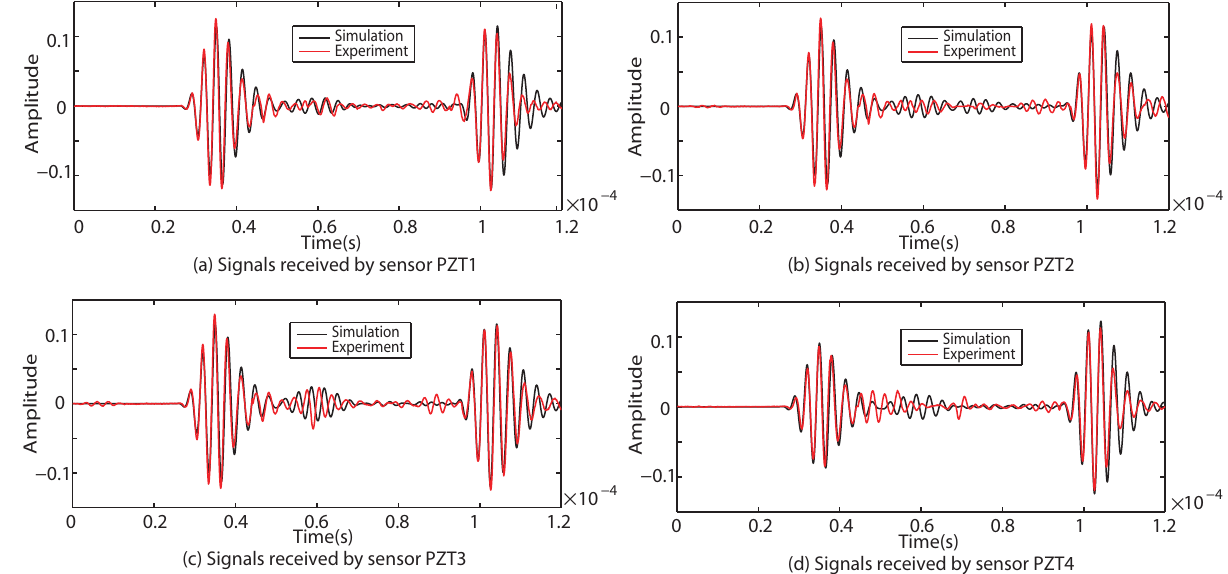
Figure 9. Comparison of experimental and simulation results under Case I.